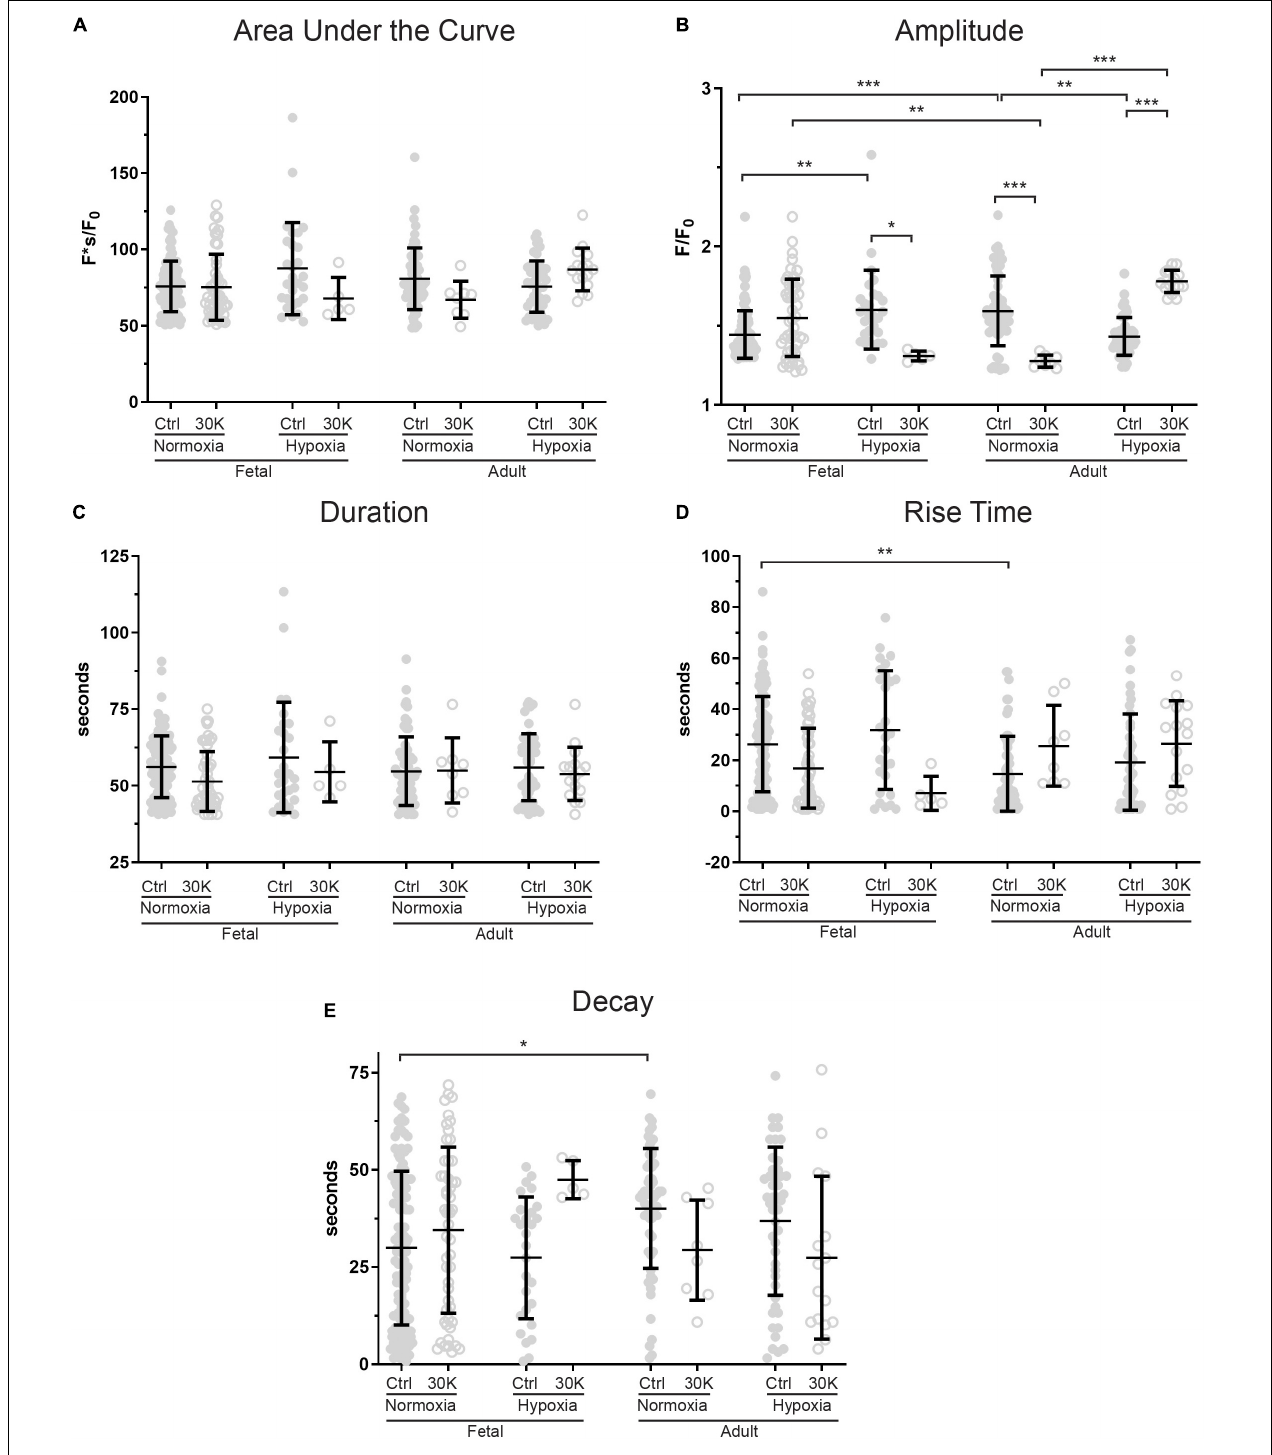
FIGURE 5 | Long-term hypoxia has minimal effect on the magnitude or temporal aspects of long duration Ca 2 + oscillations in fetal and adult sheep. Effects of artificial membrane depolarization with 30 mM K, long-term hypoxia, and animal age on (A) area under the curve, (B) amplitude of the fractional fluorescence, (C) duration of the fluorescent event, (D) rise time for fractional fluorescence in the cytosol and (E) decay time for cytosolic fractional fluorescence. Bars represent mean ± SD for each parameter; closed circles specify control conditions, and open circles treatment with 30K. * P < 0.05, ** P < 0.01, *** P < 0.001 indicate significance based on a Kruskal–Wallis ANOVA with a Dunn’s multiple comparisons test based on ranks. Control recordings were made in 116/3 FN, 28/4 FH, 61/3 AN, and 48/4 AH ROIs and animals, respectively. 30K recordings were made in 52/3 FN, 5/4 FH, 8/3 AN, and 16/4 AH ROIs and animals, respectively.